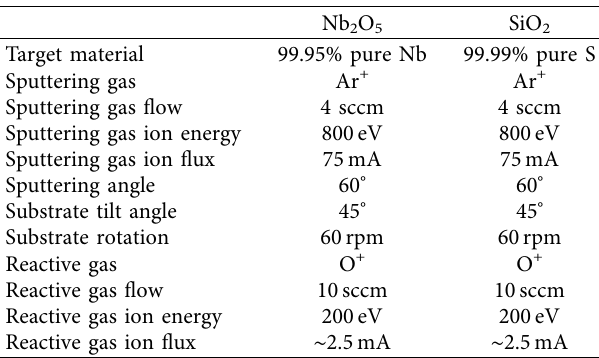
2 O 5 and SiO 2 flms